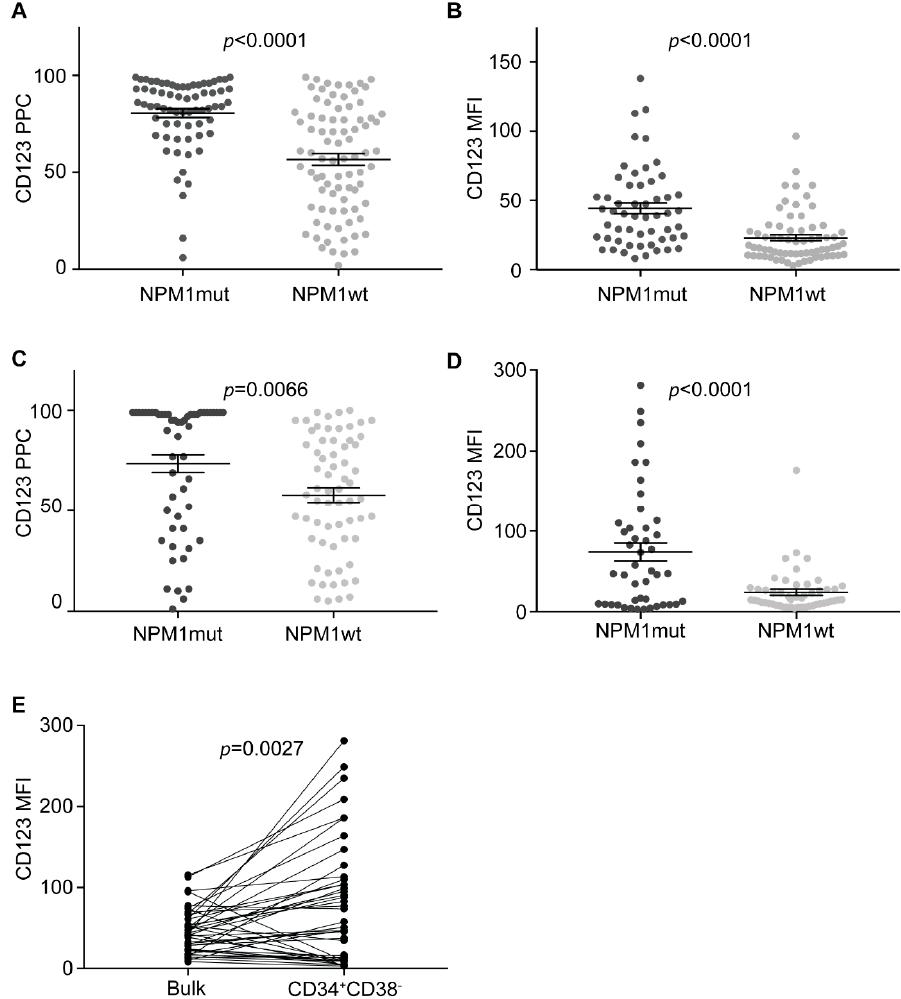
Figure 2. CD123 is highly expressed on NPM1 mut AML cells. ( A ) CD123 PPCs on NPM1 mut and NPM1 wt AML bulk cells in all samples ( n = 151). Unpaired t -test. ( B ) CD123 MFIs on NPM1 mut and NPM1 wt AML bulk cells in all samples available ( n = 122). Unpaired t -test. ( C ) CD123 PPCs on NPM1 mut and NPM1 wt CD34 + CD38 − cells in all samples available ( n = 119). Unpaired t -test. ( D ) CD123 MFIs on NPM1 mut and NPM1 wt CD34 + CD38 − cells in all samples available ( n = 96). Unpaired t -test. ( E ) CD123 MFIs on NPM1 mut bulk AML cells compared to CD34 + CD38 − cells at diagnosis in all samples available ( n = 44). Paired t -test. Bars represent mean and standard